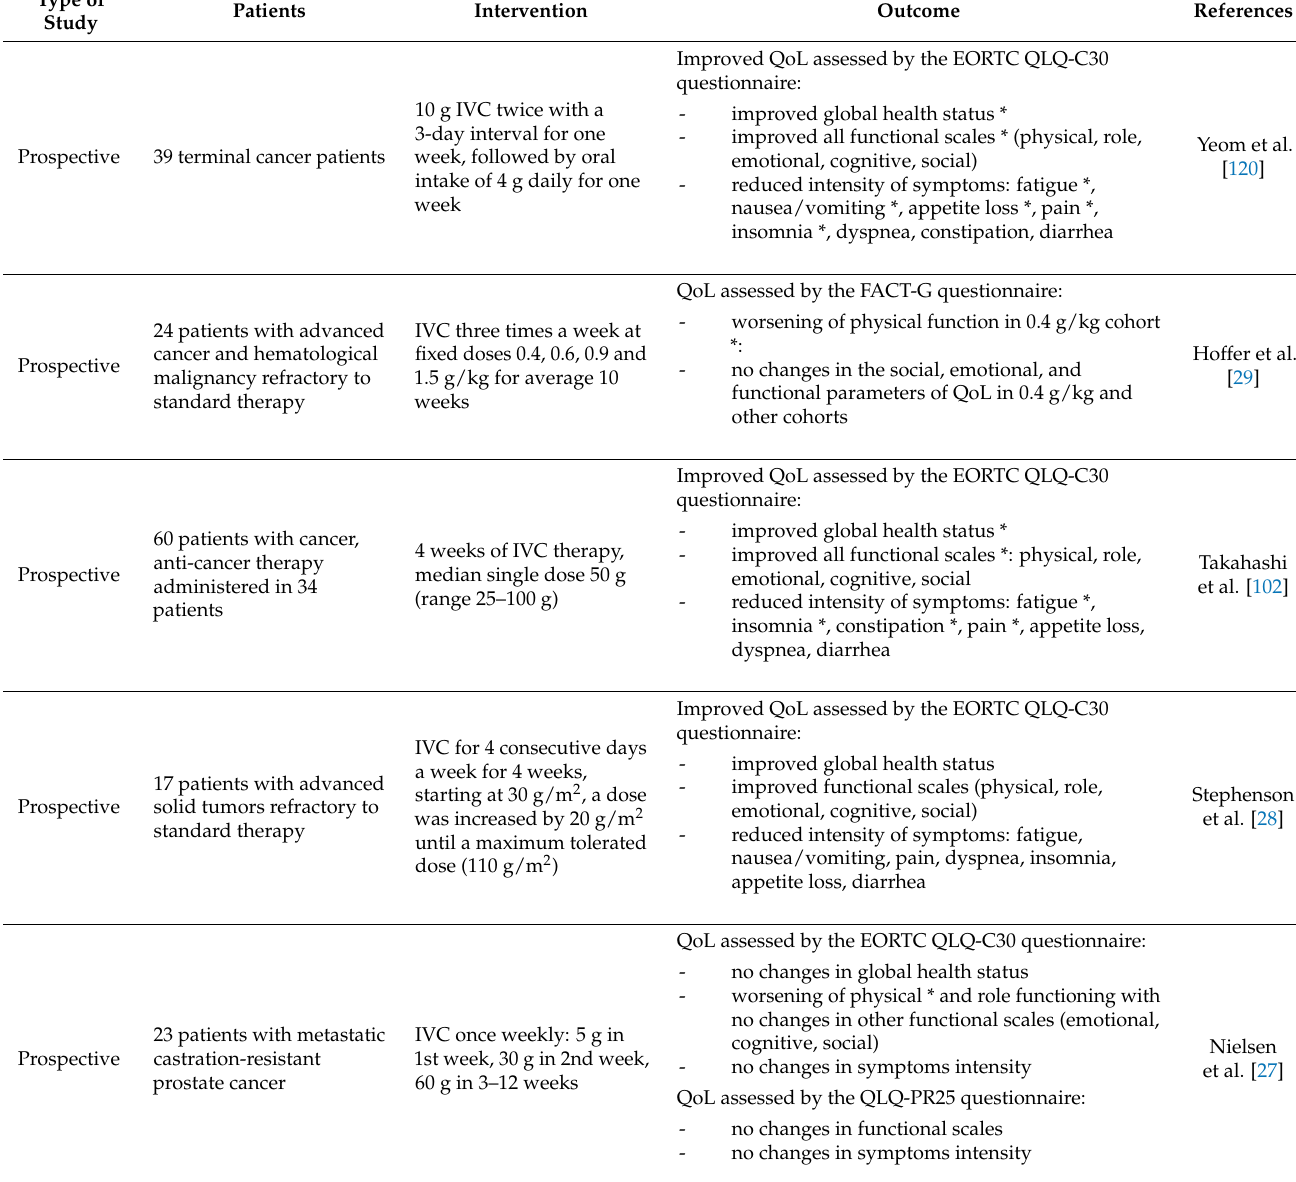
Table 1. Effect of high-dose intravenous vitamin C (IVC) on quality of life, performance status, and symptom severity in cancer